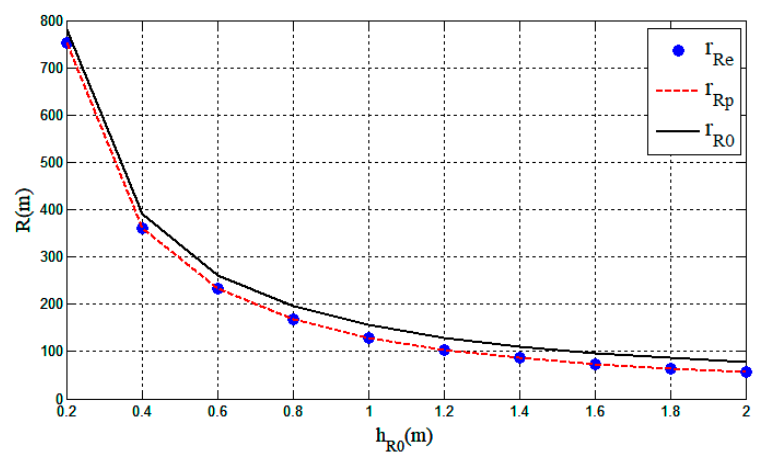
Figure 8. Equivalent radius of a frame structure equipped with SLDRFPB.